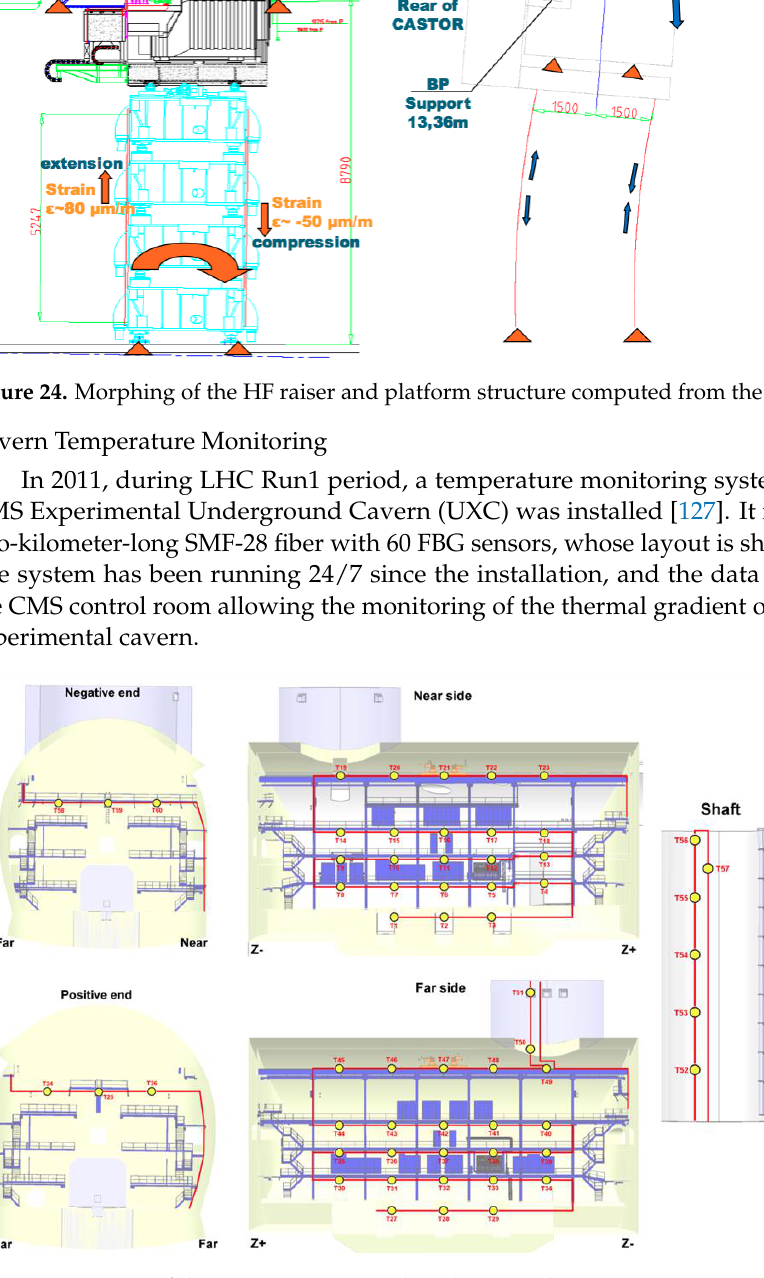
23 of 42 Figure 23. Layout of the FBG-based monitoring system installed on the CASTOR platform structure.